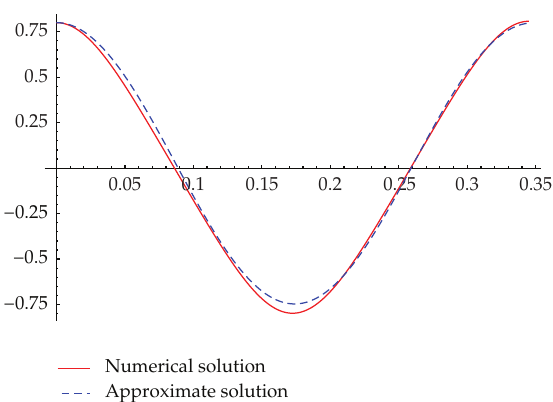
Figure 2: Comparison between the numerical solution of (cid:2) 1.1 (cid:3) and the approximate solution (cid:2) 3.7 (cid:3) for A (cid:9) 0 . 8, m (cid:9) 2, k 1 (cid:9) 200, k 2 (cid:9) 1000, q (cid:9) 0 . 1, ω 1 (cid:9) 2 . 7, ω 2 (cid:9) 1 . 0, f (cid:9)